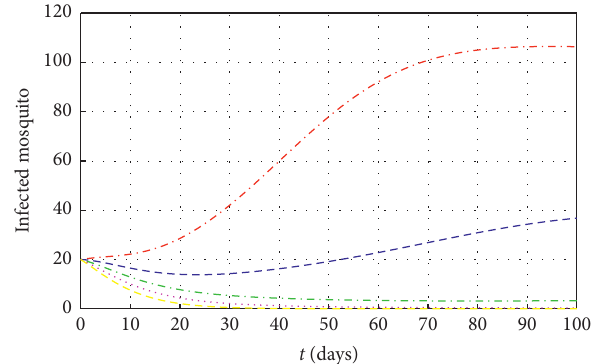
Figure 7: Population of infected mosquitoes with and without awareness (without awareness (red line); with low to high awareness rate awareness (blue, green, magenta, and yellow line)).